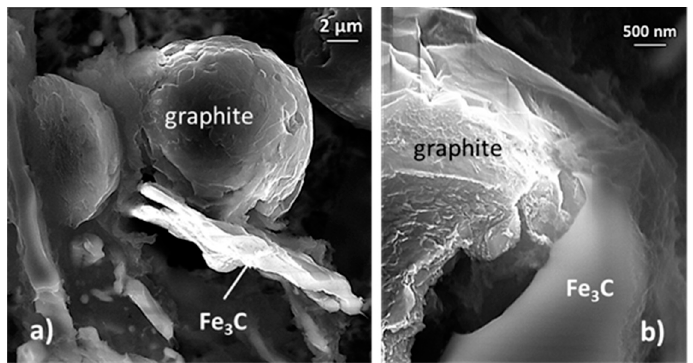
Figure 43. SEM micrographs illustrating the growth of graphite hemispheres: ( a ) growth of hemispheres on iron carbide; ( b ) late growth; the contact with the carbide is almost completely lost. See Reference [111] for experimental conditions.